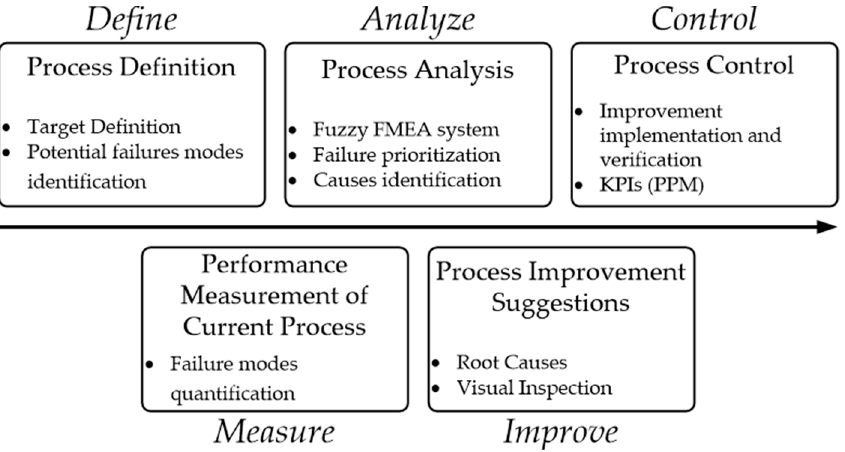
Figure 2. Fuzzy FMEA system integration in DMAIC cycle.